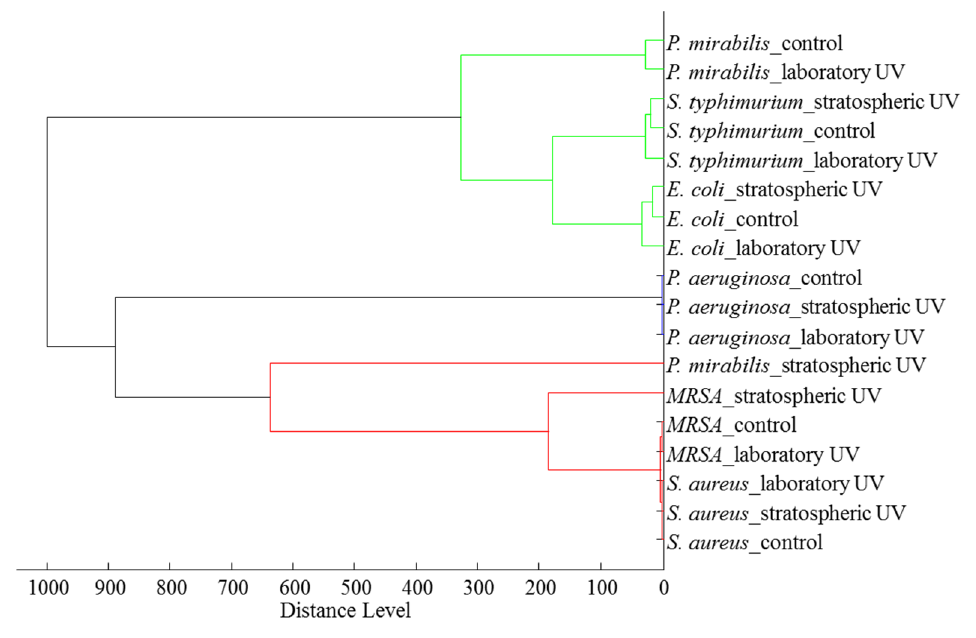
Figure 7. Dendrogram from the mass spectra of bacteria without UV exposure and after exposure to the laboratory and stratospheric UV. Mass spectra were collected in the m/z range 2.000–20.000. For MALDI-TOF analysis, 1 µL of extract of each bacterial culture was used. The dendrogram was created in MALDI BioTyper TM